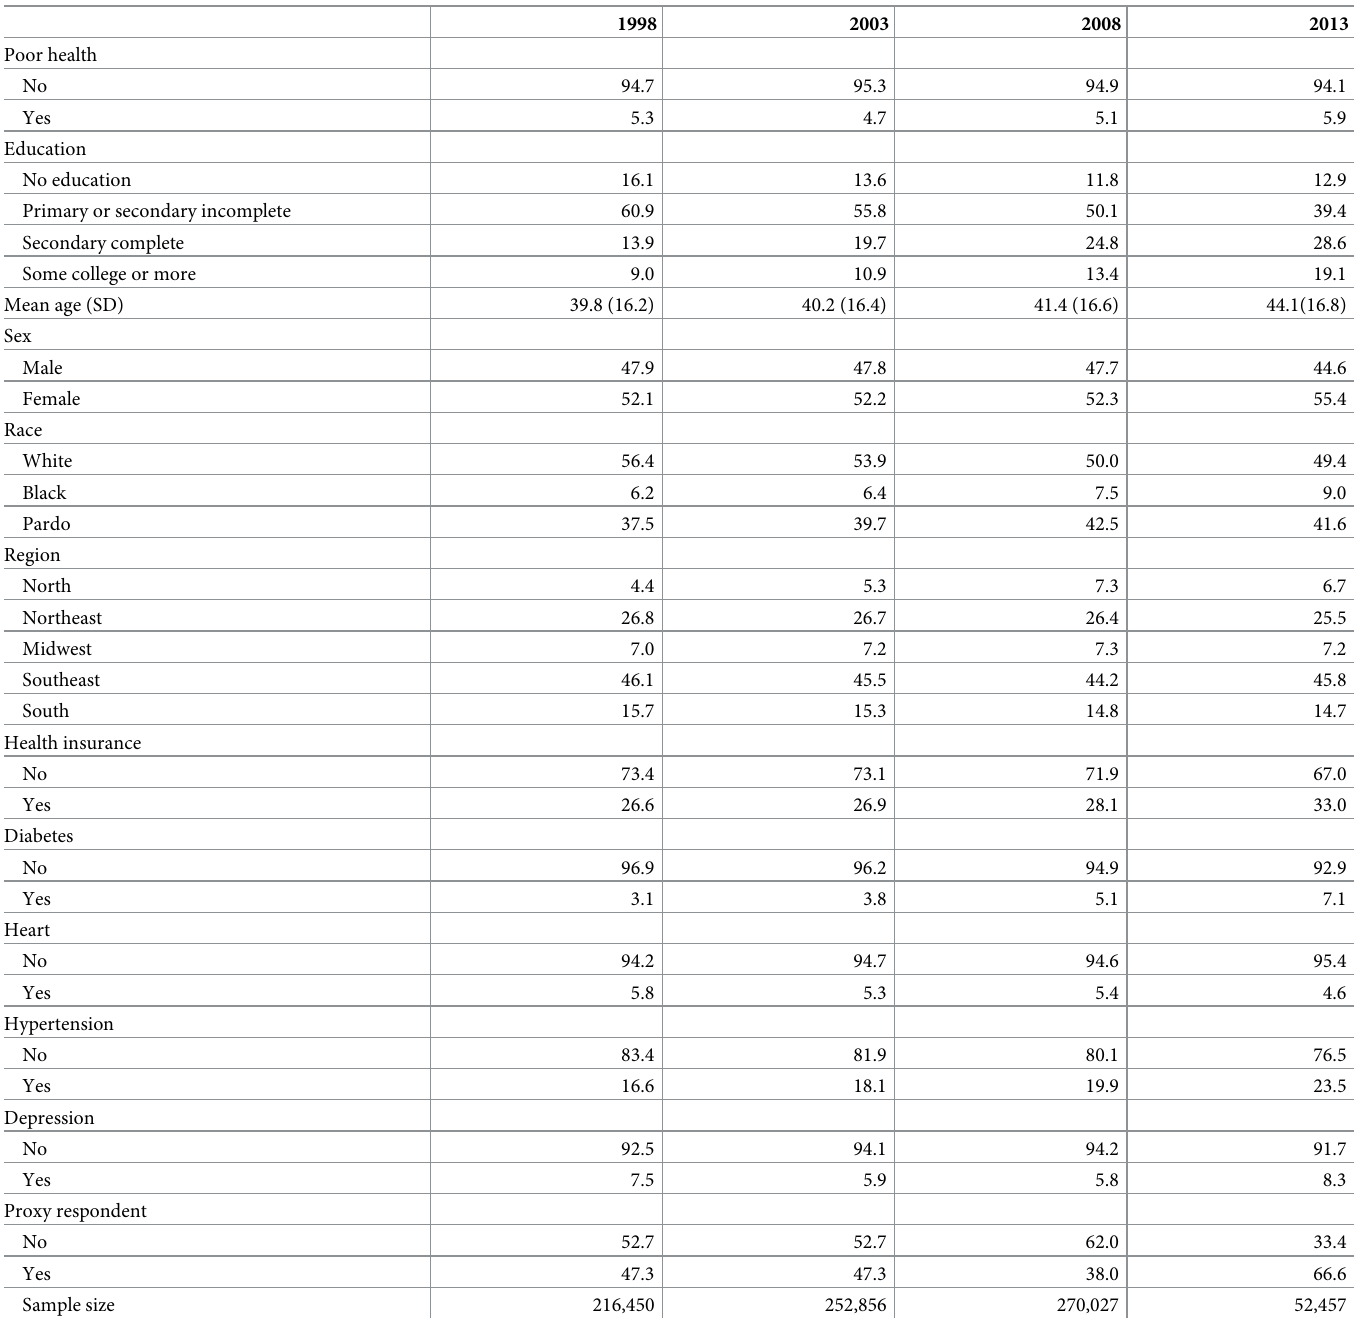
Table 1. Descriptive statistics, Brazil: